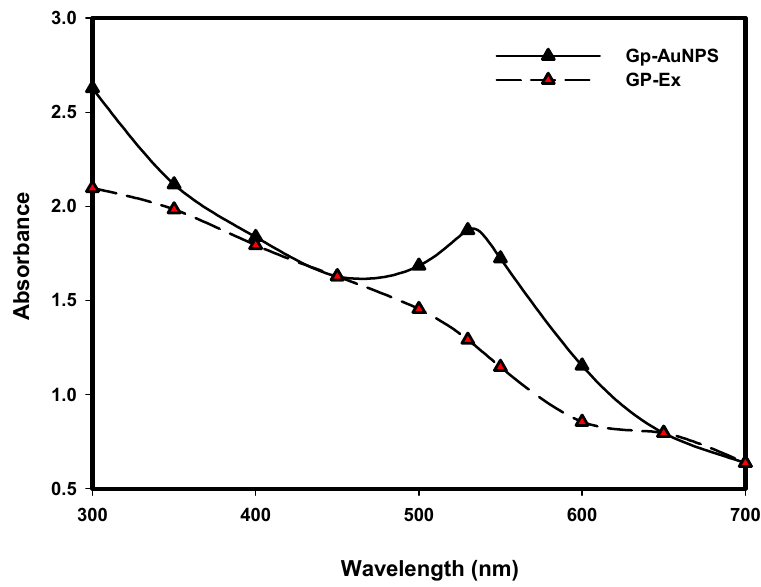
Figure 1 . UV–VIS spectra of GP-AuNPs (black) and GP-Ex (red).